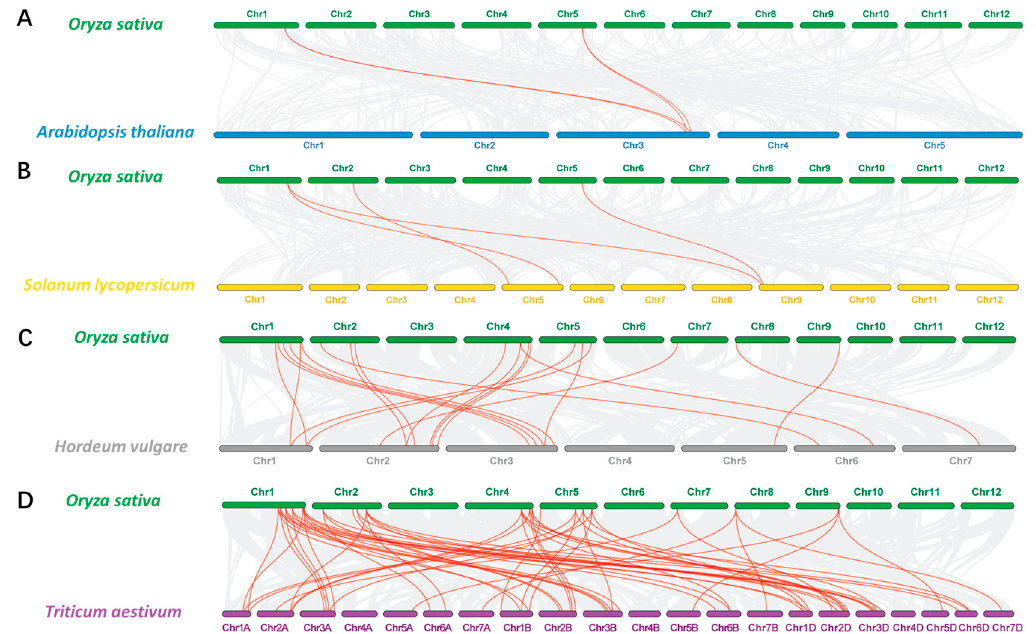
Figure 6. Collinearity relationship of the RCC1 genes in rice and other four plant species, including Arabidopsis ( A ), tomato ( B ), barley ( C ) and wheat ( D ). Gray lines in the background indicate the syntenic blocks between rice and other plant genomes, while the red lines highlight the syntenic RCC1 gene